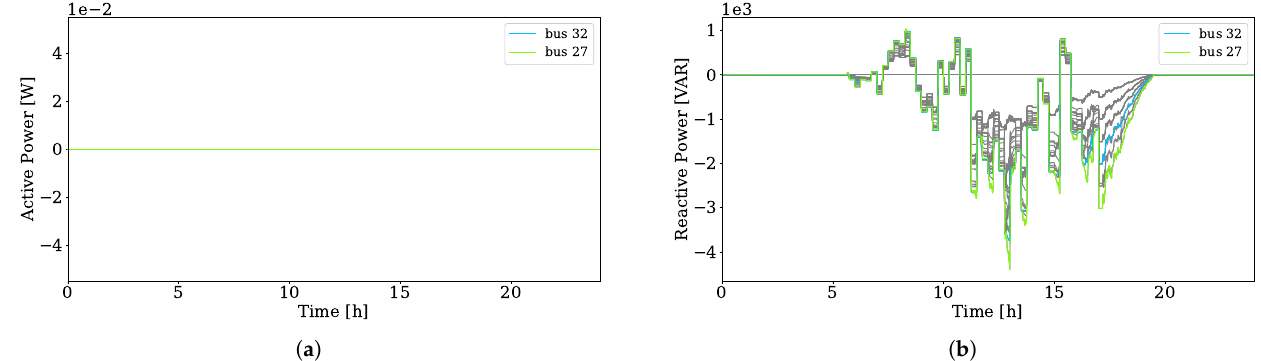
Figure 10. Results of the hierarchical control #2. ( a ) Active power curtailment PV set-points; ( b ) reactive power PV set-points.